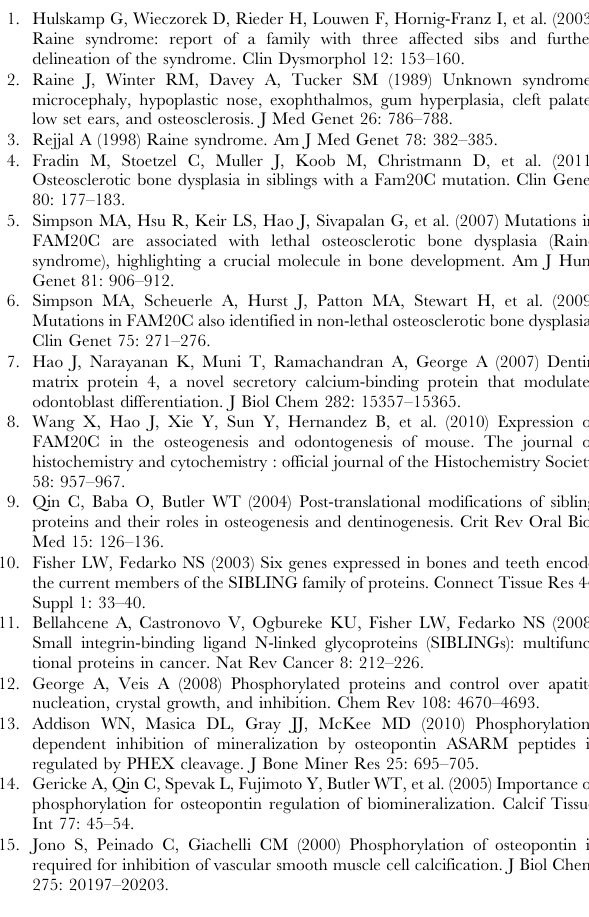
Figure S4 Sequence of FAM20C and mutant isoforms. a) Amino acid sequence of human FAM20C (NP_064608.2). Amino acids altered in human patients or by our site-specific mutagenesis are identified by colors (red, from patients, blue, in conserved motifs) and numbers above. b) Tabulation of the location of mutated amino acids, to account for differences in annotation due to different sequence entries of human FAM20C, and differences in size of human versus mouse FAM20C. Figure S5 Localization of FAM20C mutant isoforms. Examples of localization of the indicated V5-tagged FAM20C mutant proteins (green) transfected into 293 cells, as compared to a Golgi markers (Giantin, a–h, red) or an ER marker (anti-KDEL, i–p,